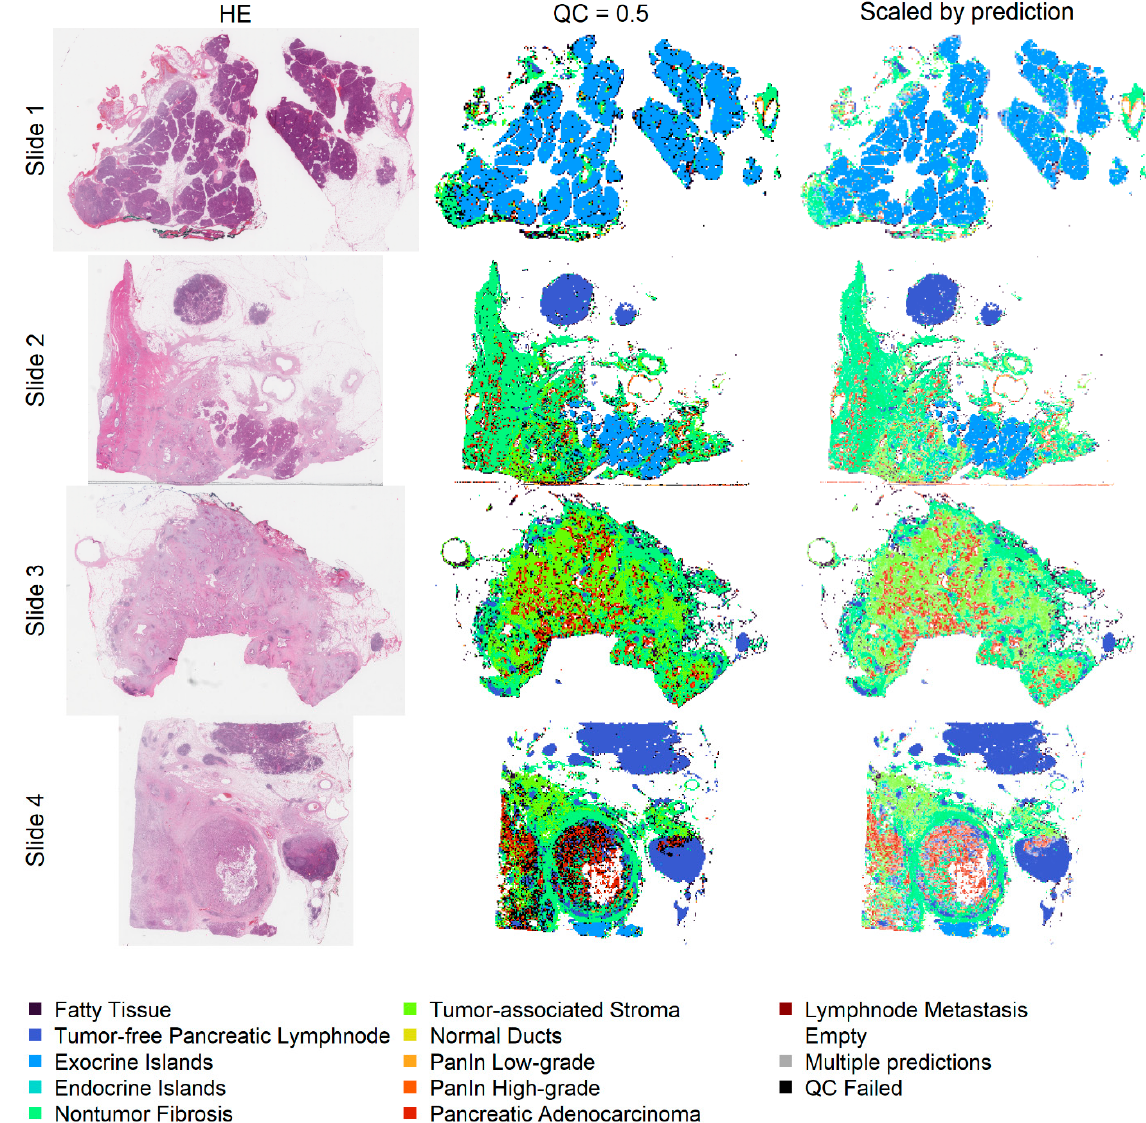
Figure 5. The first column shows the original slides, the second column shows the patch classification heatmaps with a QC of 0.5, and in the last column, the patch color is mixed with white depending on the prediction probability (1 results in no mixing with white). Non-tumor pancreatic tissue (first row), areas with a high content of pancreatic adenocarcinoma (second to fourth rows), and lymph node metastases (fourth row) can be easily identified.